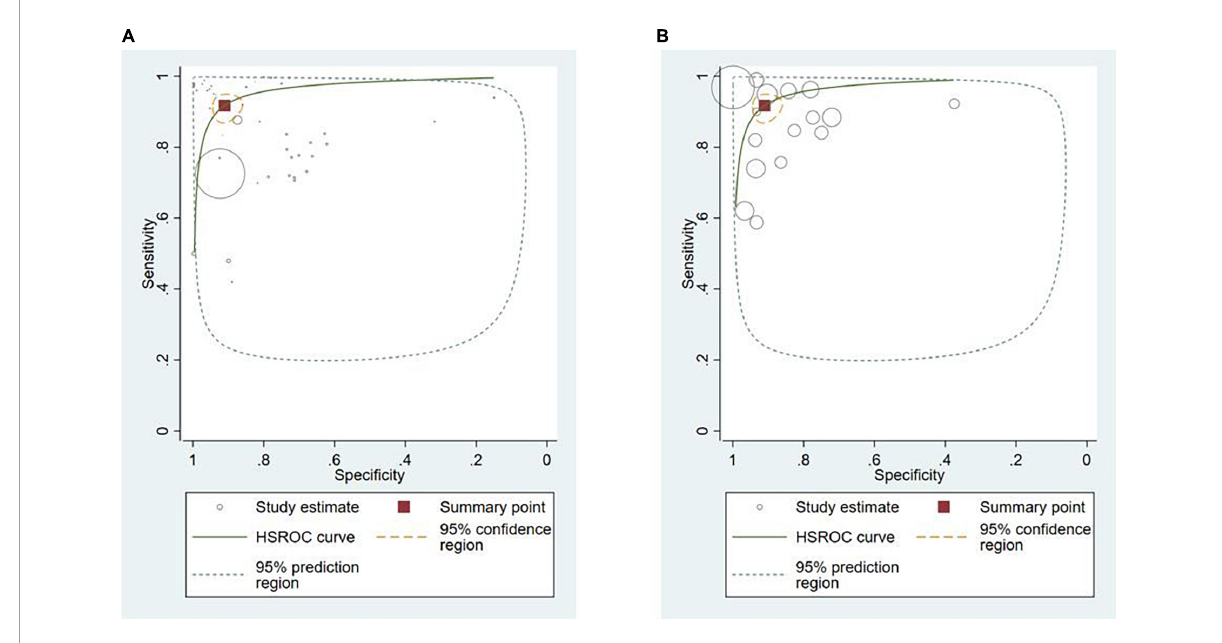
FIGURE5 Hierarchical summary ROC curve for detecting GI luminal diseases. (A) GI polyps and (B) GI